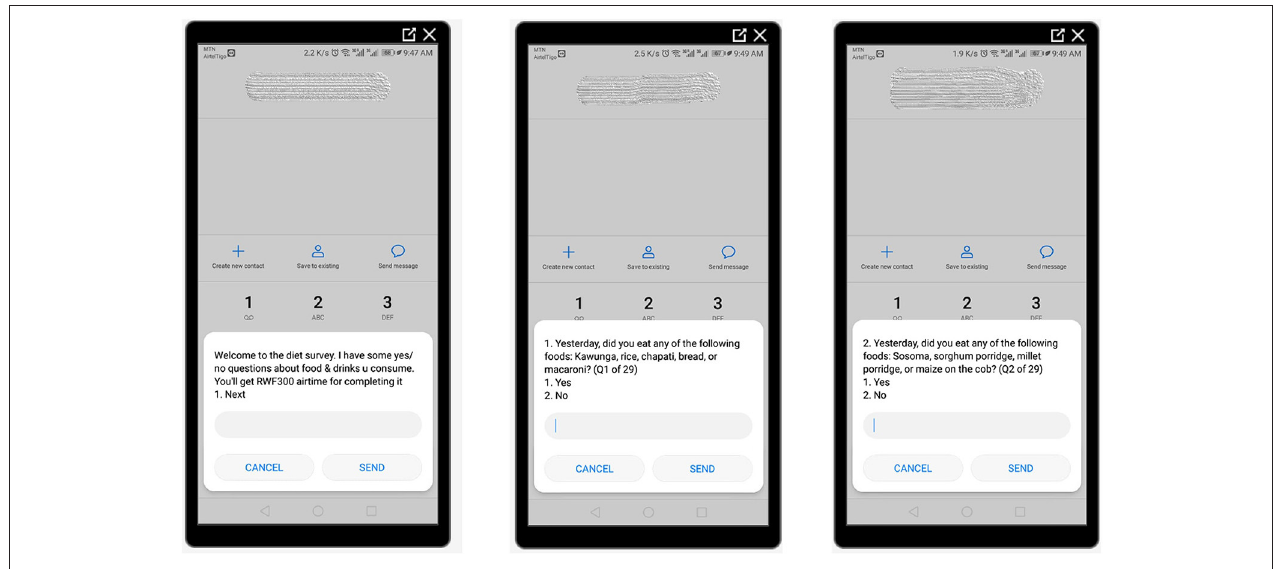
FIGURE 2 | Diet quality questionnaire presented via